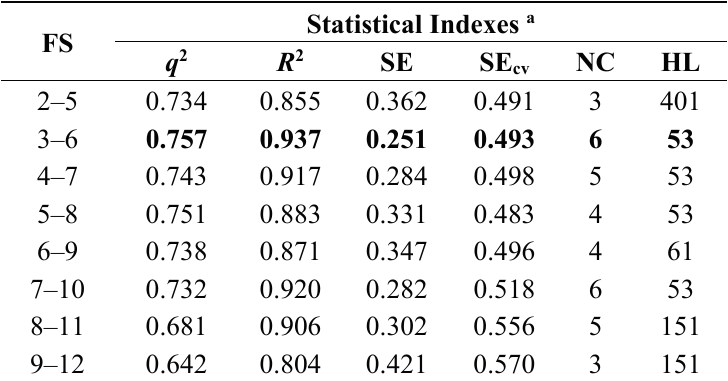
Table 2. Summary of the HQSAR statistical indexes for the influence of various fragment sizes (FS, 2–12 atoms) using the fragment distinction parameter A/B/C/Ch/DA for the